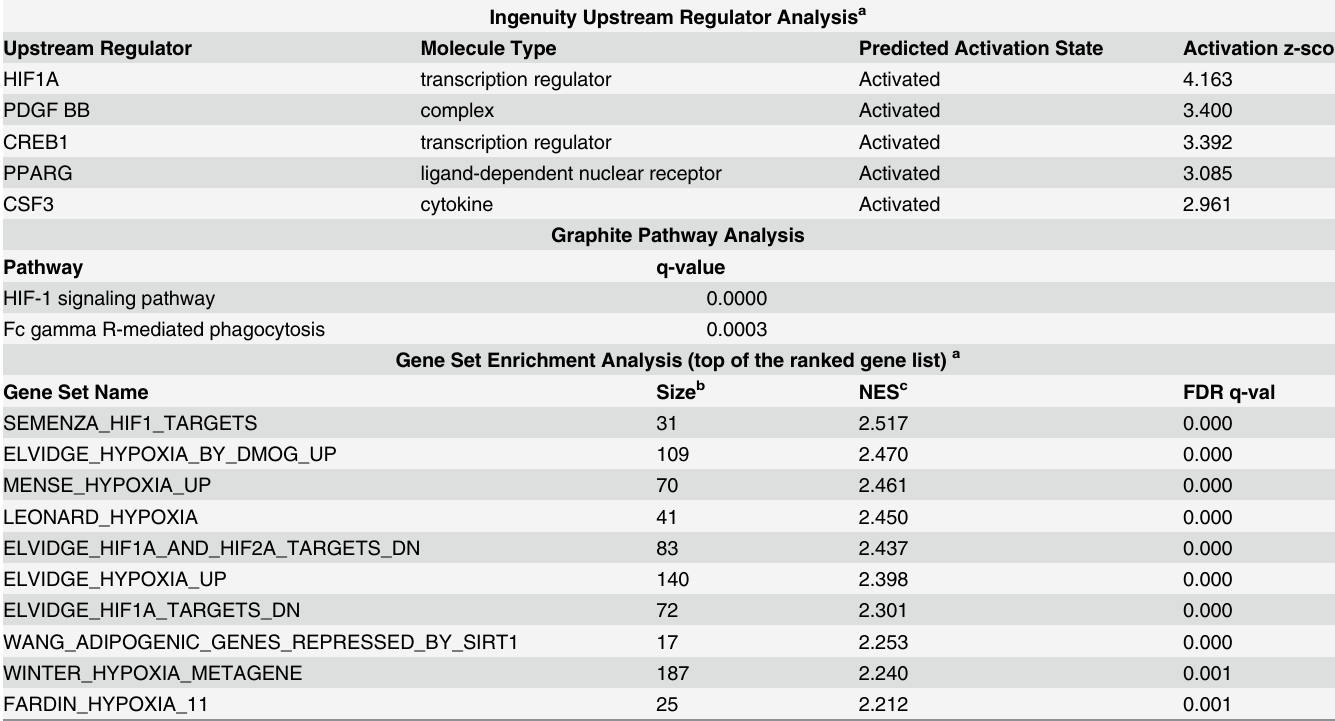
Table 3. Pathway